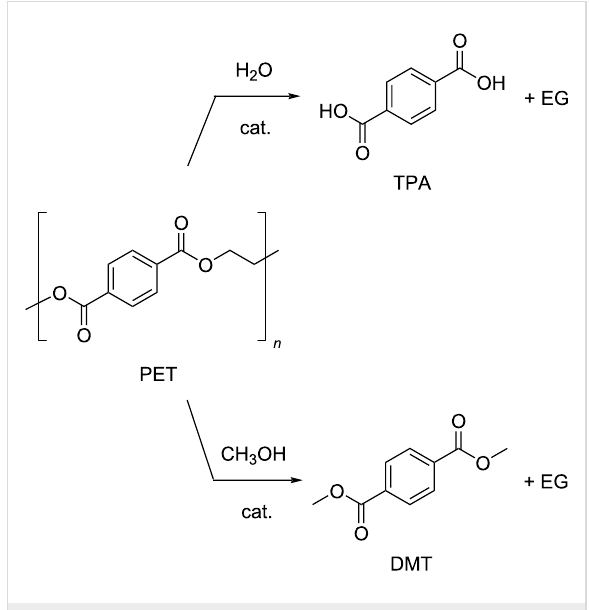
Scheme 4: Catalytic hydrolysis (top) and methanolysis (bottom) reac- tions of PET.